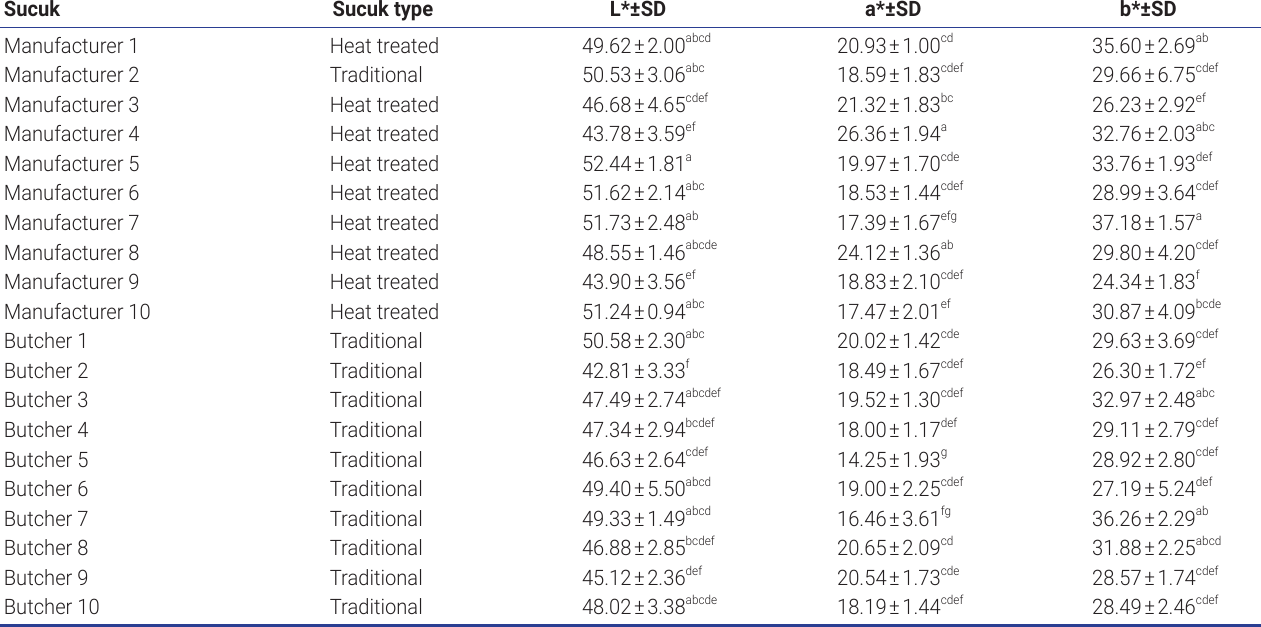
Table 5. Mean inner surface L*, a*, b* values of a total of 60 sucuk samples